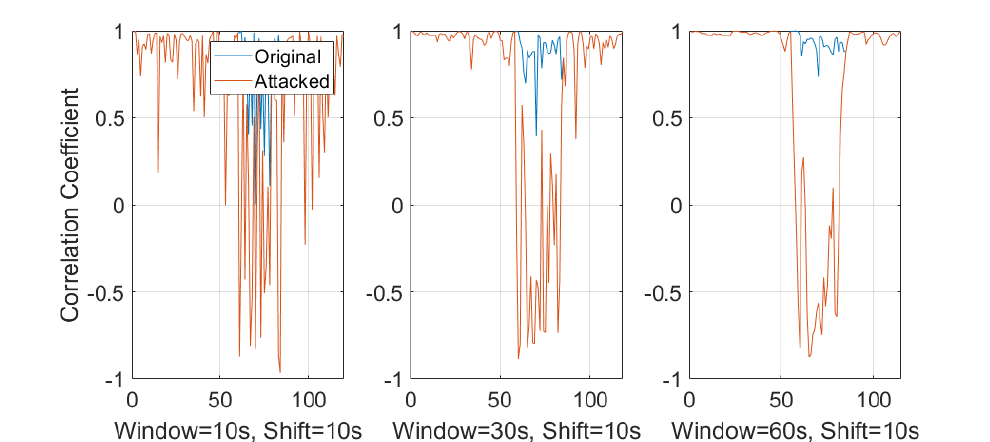
Figure 14. Correlation coefficient with 10 s, 30 s, and 60 s sliding window with a shift step size of 10